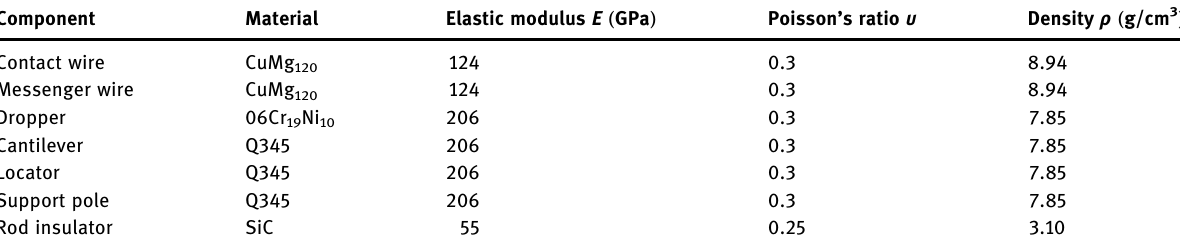
Table 1: Mechanical parameters of catenary components